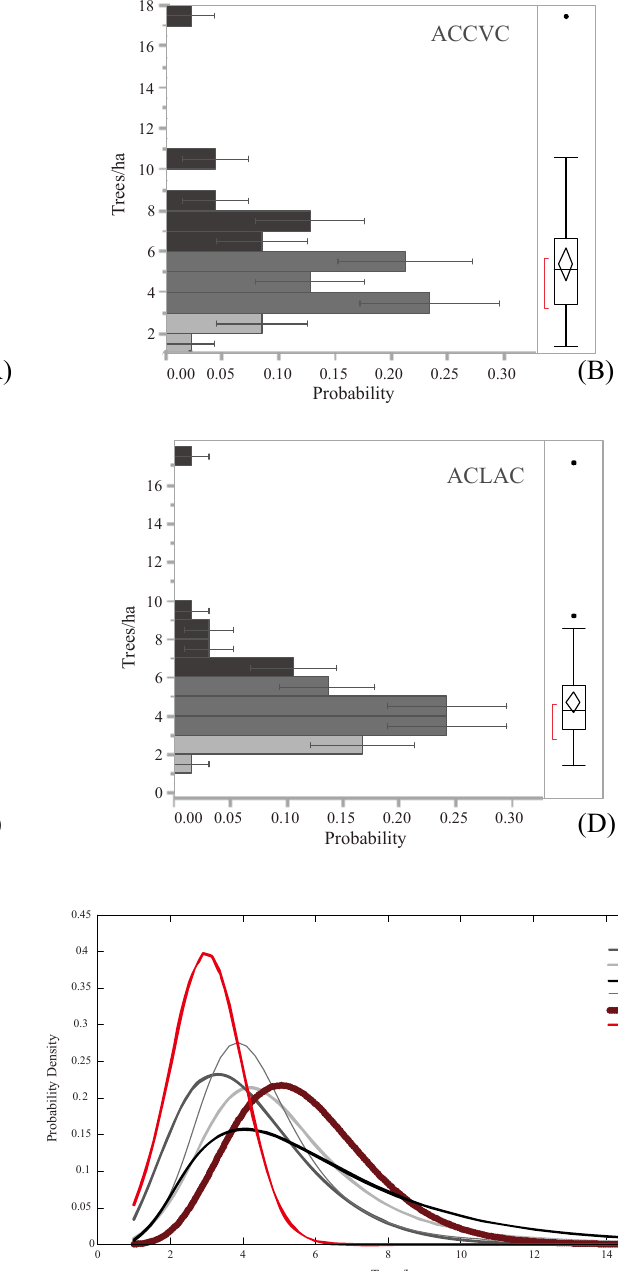
Figure 6. Probability distributions based on trees per hectare proposed to be logged for management plans in five Conservation Areas in Costa Rica ( A – E ); light colors on the bars represent low logging densities (trees/ha); more intense gray color indicates conventional logging practices and dark gray bars very heavy logging; ( F ) shows a fitted probability density function for each Conservation Area compared to a low density logging fit (3